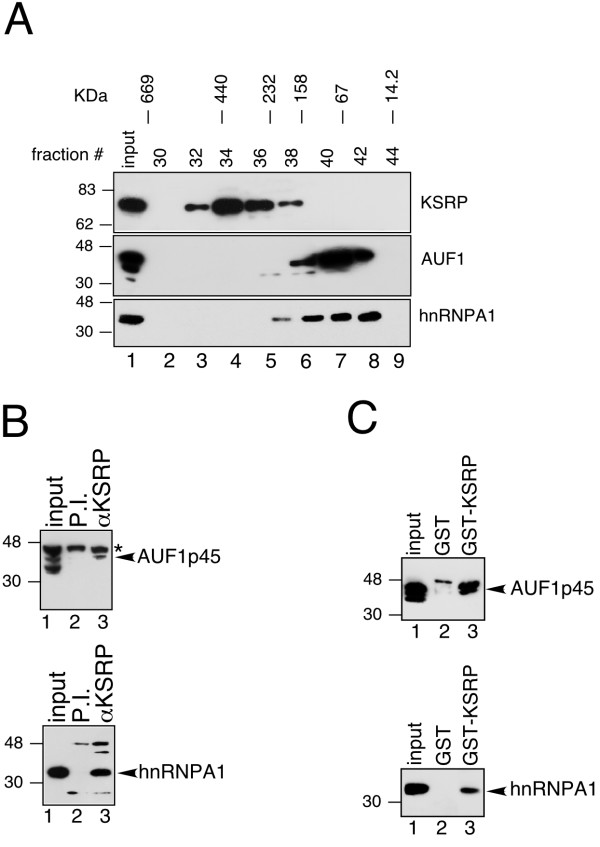
KSRP associates with AUF1p45 and hnRNPA1 in cytoplasmic extracts of aT3-1 cells. (A) S100 extracts from αT3-1 cells were subjected to gel filtration chromatography on a Superose 6 column. Aliquots of the eluted fractions were analyzed by Western blotting using the indicated antibodies. (B) RNase A-treated S100 extracts from αT3-1 cells were immunoprecipitated with preimmune (lane 2) or anti-KSRP (lane 3) sera and analyzed by immunoblotting with either anti-AUF1 (top) or anti-HnRNPA1 (bottom) antibodies. The arrows mark the position of either AUF1p45 or hnRNPA1, while the asterisk marks a anti-AUF1 cross-reacting band. (C) GST-pulldown of either endogenous AUF1p45 (top) or endogenous hnRNPA1 (bottom) from S100 extracts of αT3-1 cells using either control GST or GST-KSRP. Proteins were analyzed by immunoblotting using the indicated antibodies. The arrows mark the position of either AUF1p45 or hnRNPA1.